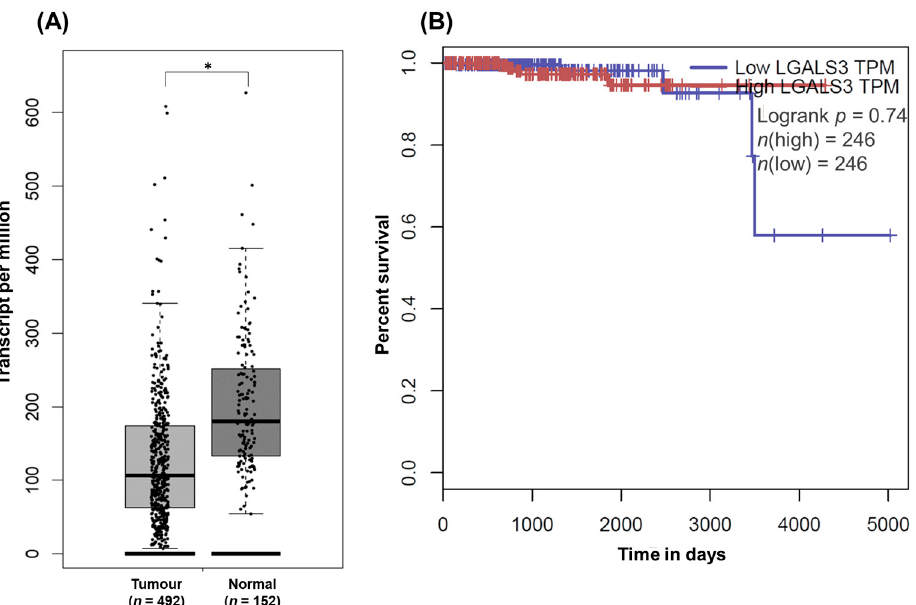
Figure 6. UALCAN analysis of: Gal-3 expression in normal and tumour prostate tissues from TCGA PCa cohorts ( A ), in normal and tumour prostate tissues with different GSs ( B ), Gal-3 promoter methylation levels in normal and tumour prostate tissues from TCGA PCa cohorts ( C ), impact of Gal-3 expression on PCa patient survival ( D ). (* p < 0.05; **** p < 0.0001).